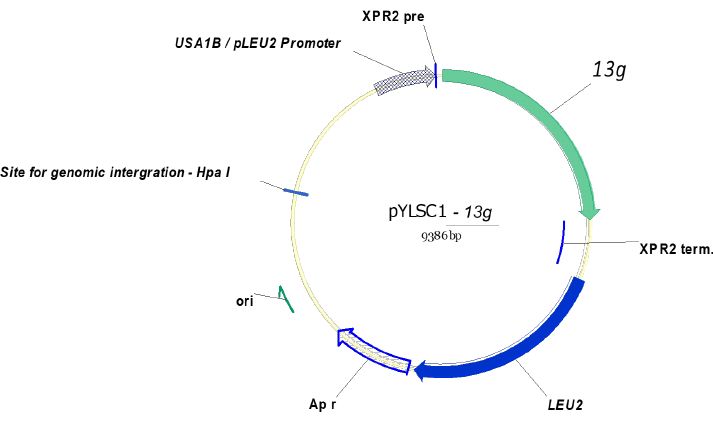
Figure 1. Plasmid map of pYLSC1-